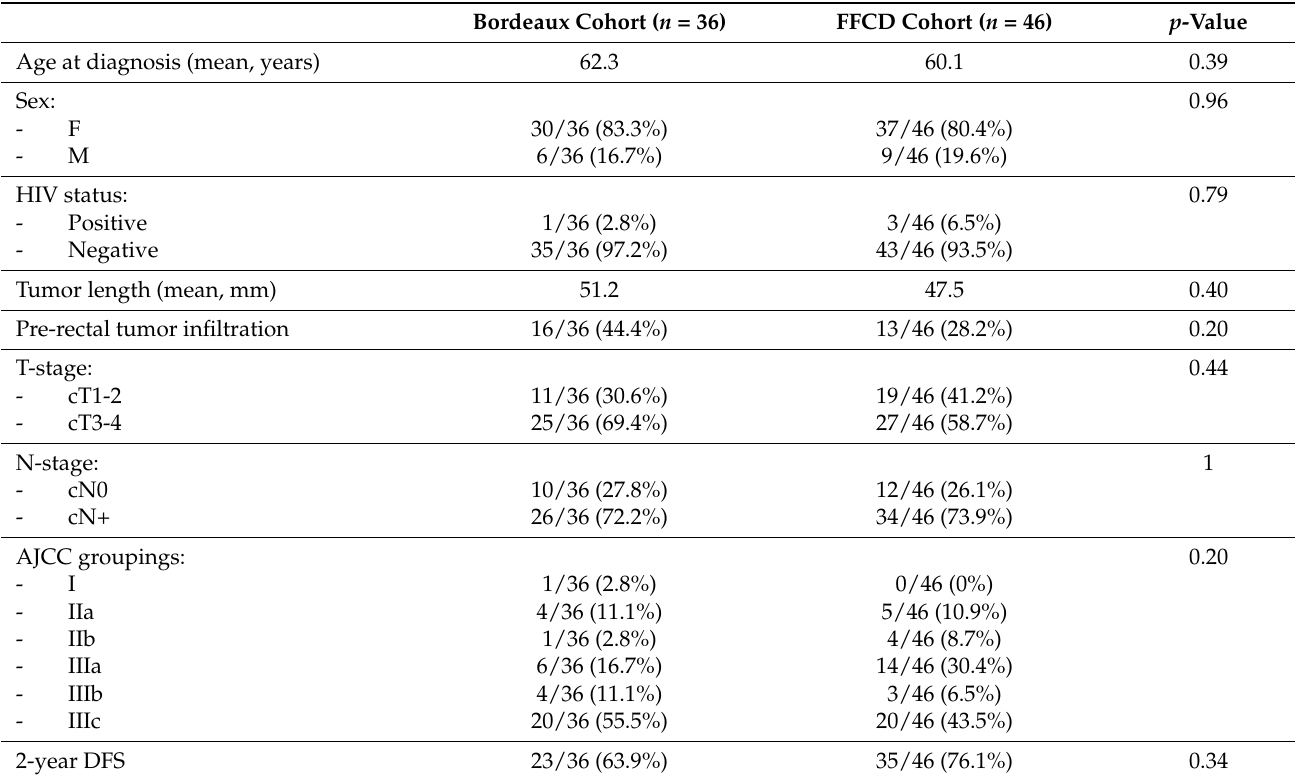
Table 1. Patient and tumor characteristics in the two subsequently blended cohorts. (Abbreviations: F = female, M = male, HIV = human immunodeficiency virus, DFS = disease-free